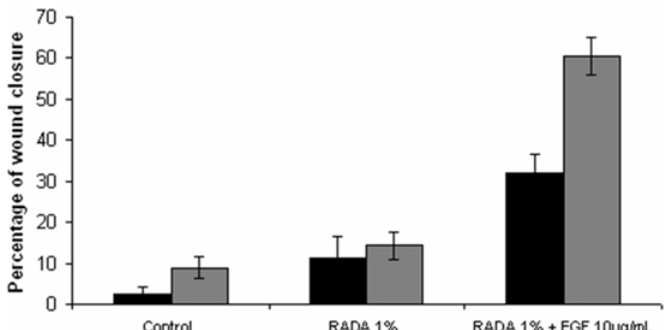
Figure 6. Percentage of wound closure after 24 hours (black bars) and 48 hours (grey bars). Data points are average of N=7 and error bars represent 6